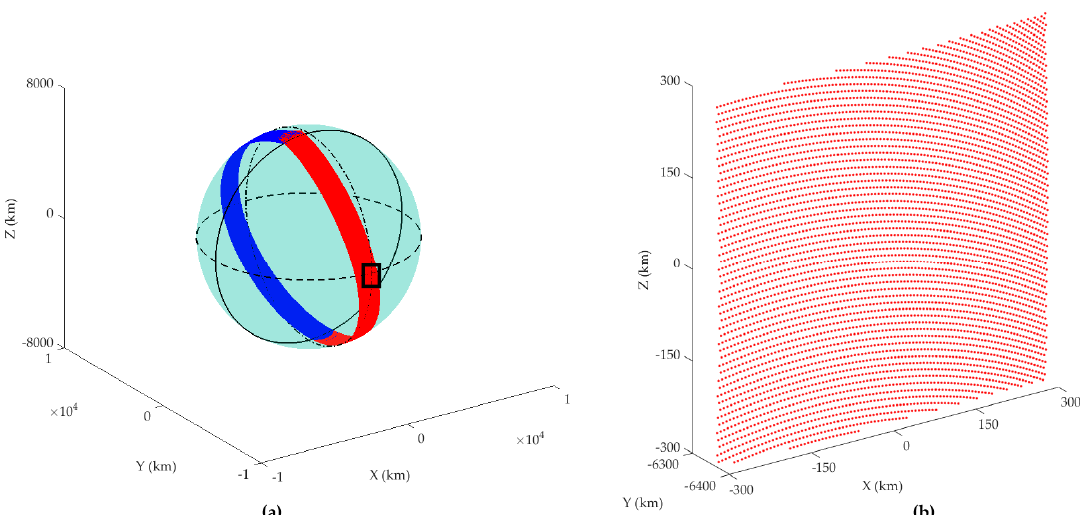
Figure 2. The actual scan positions of the FY-3C MWRI in the earth spherical coordinate system. ( a ) An example of the scanning positions of a descending mode scan (blue) and the following ascending mode scan (red); ( b ) Enlarged view of the black box in ( a ).